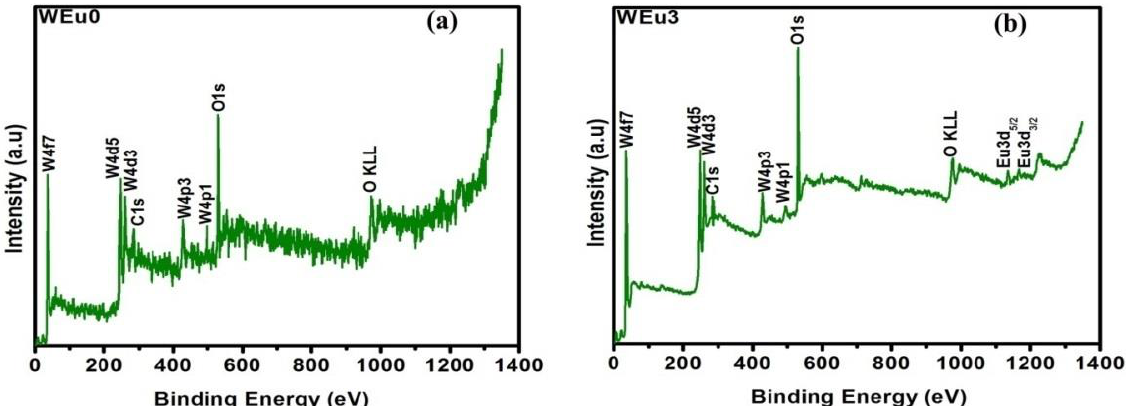
Figure 8. XPS survey spectra of ( a ) un-doped (WEu0) and ( b ) 3 wt% Eu 3+ -doped (WEu3) WO 3 films annealed at 600°C.